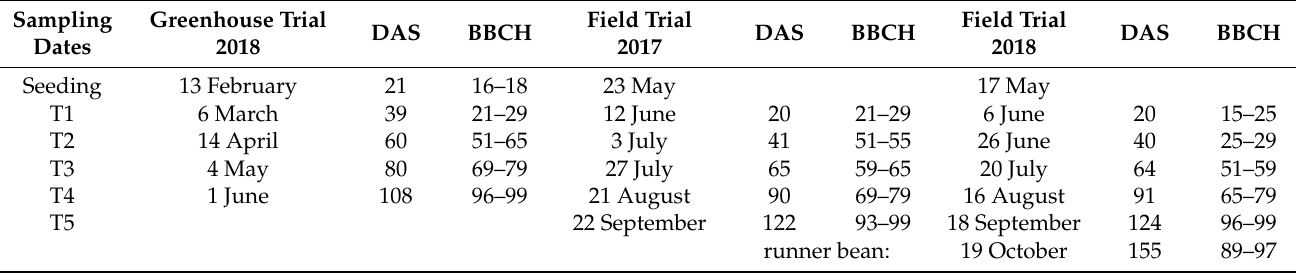
Table 1. Codes for sampling, sowing, and harvest dates (DAS = date after seeding), and the BBCH stage/range of the examined soybean